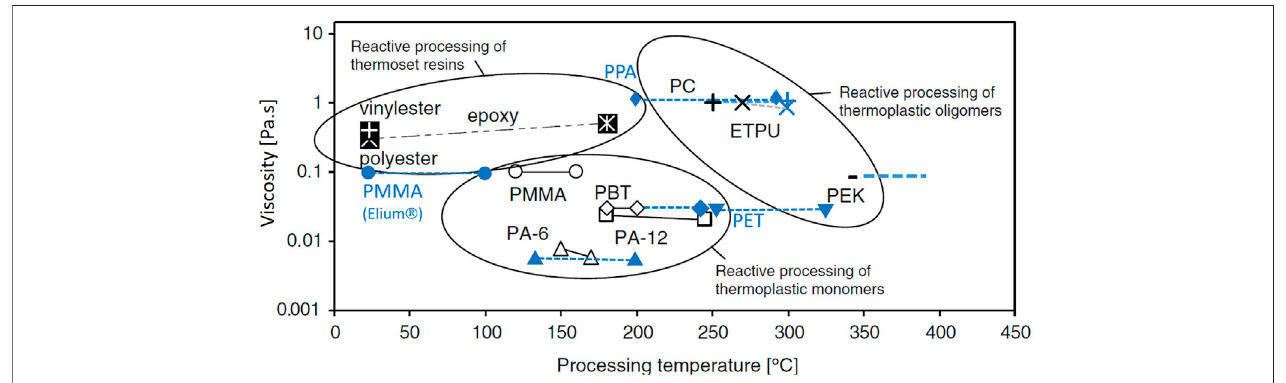
FIGURE 1 | Processing temperature and viscosity ranges of various polymers suitable for reactive processing (adapted from (van Rijswijk and Bersee, 2007), plotted in black and white, and (Qin et al., 2020), plotted in blue).